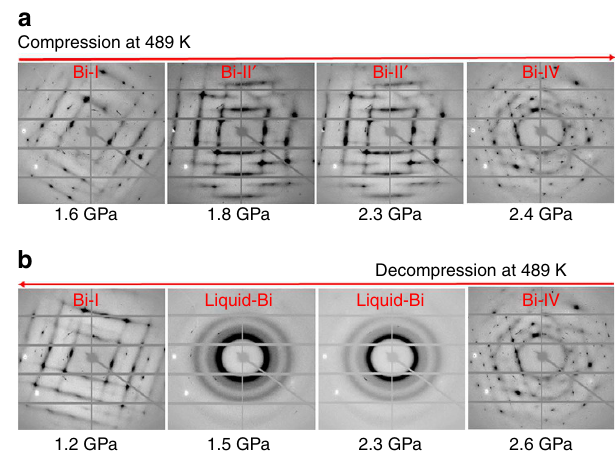
Figure 1 | Diffraction images at 489K under compression and decompression pathways. Neon serves as pressure medium to provide hydrostatic condition. The detailed phase transition sequences and indexes of crystalline phases are shown in Supplementary Fig. 2. ( a ) Bi sample is compressed from 1.0 to 3.2GPa (right red arrows). Bi-I phase transforms to Bi-II 0 at B 1.8GPa, followed by II 0 -to-IV transition at B 2.4GPa. ( b ) Bi sample is decompressed from 3.2 to 1.0GPa (left red arrows). Bi-IV melts into liquid Bi at B 2.3GPa, followed by crystallization of liquid Bi at B